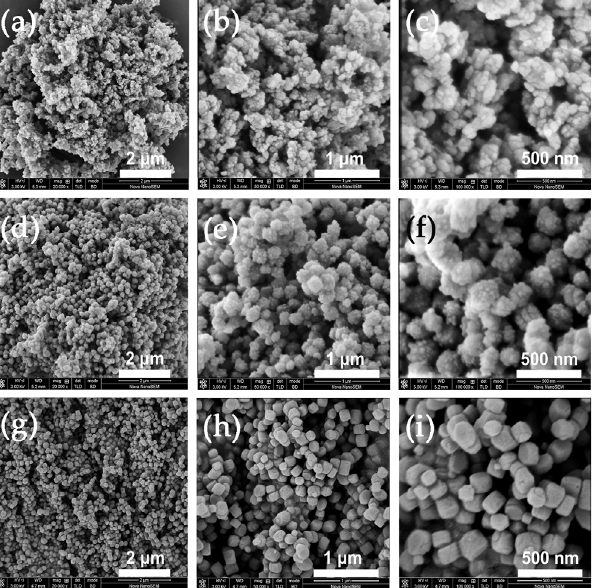
Figure 4. XRD patterns of ZSM ‐ 5 with different Si/Al ratios.